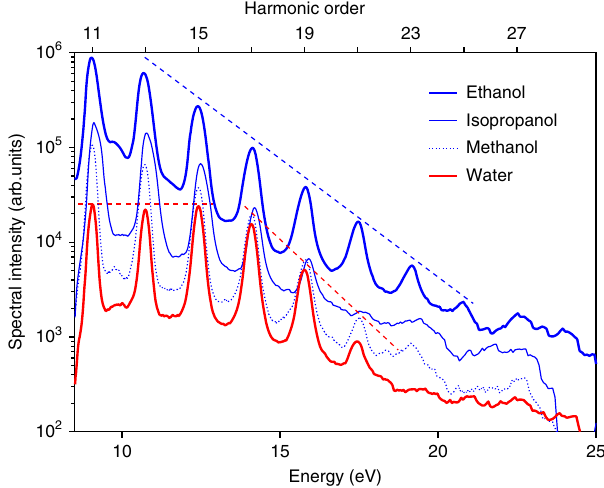
Fig. 3 Comparison of HHG from liquid water and several alcohols. HHG spectra recorded from water and three alcohols under individually optimized experimental conditions. The dashed straight lines are guides to the